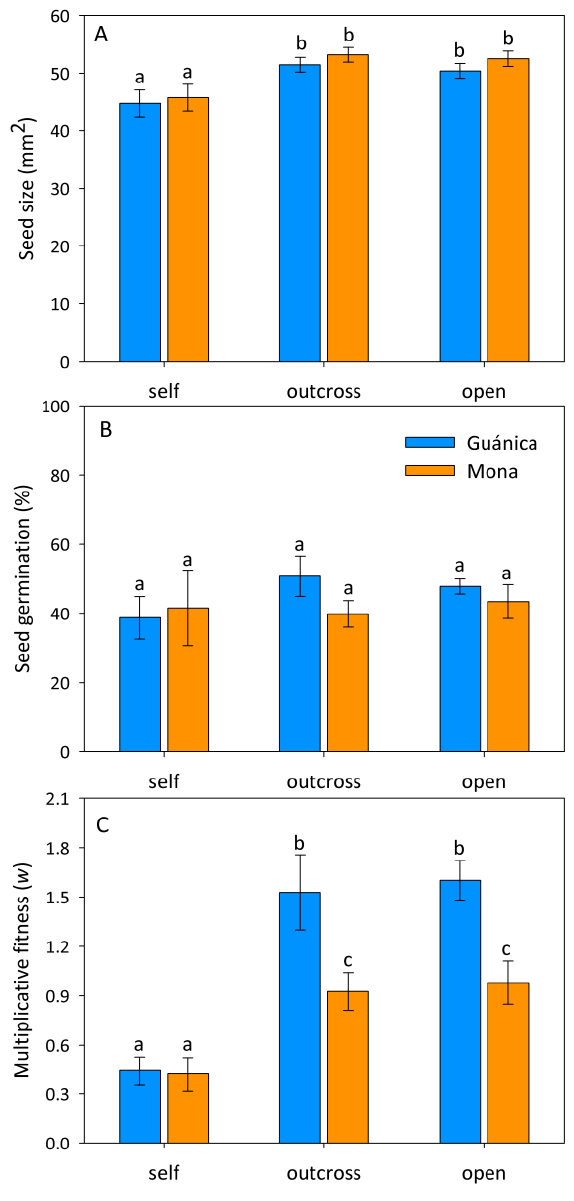
Figure 6. Means for (A) seed size (area in mm 2 ), (B) percentage of seed germination, and (C) multiplicative fitness estimates ( w ) for the different pollination treatment performed in Guánica and Mona Island. Error bars are standard error of the mean. Different letters indicate significant differences (Tukey’s post hoc tests, P < 0.05) among